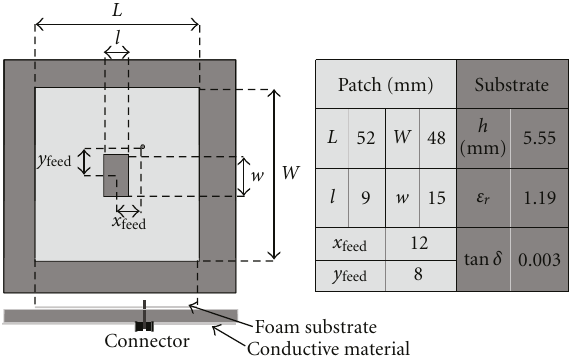
Figure 2: Topology and dimensions of the 2 . 45GHz circularly polarized wearable patch